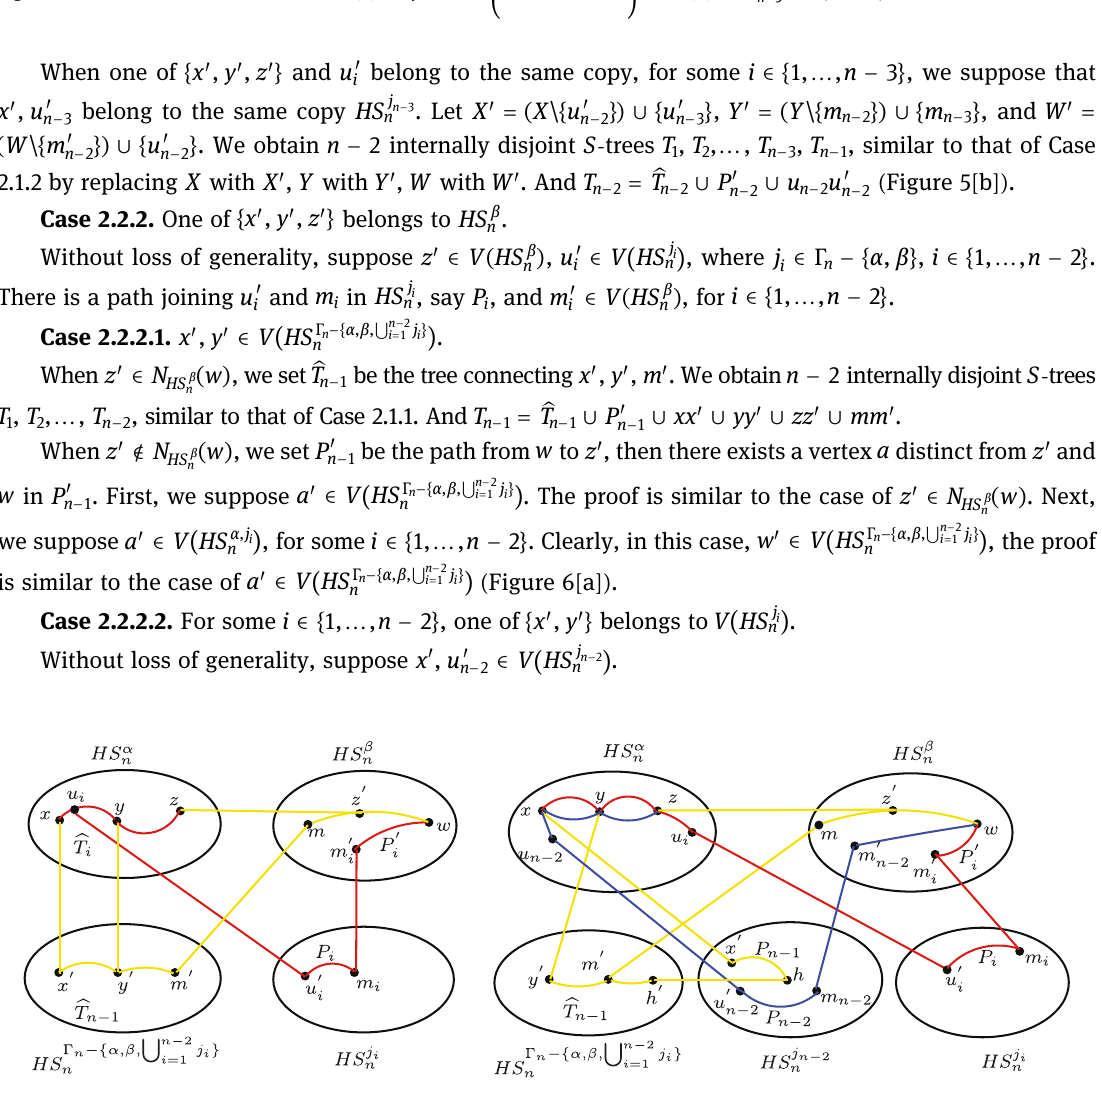
Figure 5: The illustrations of Case 2.2.1: ( a )